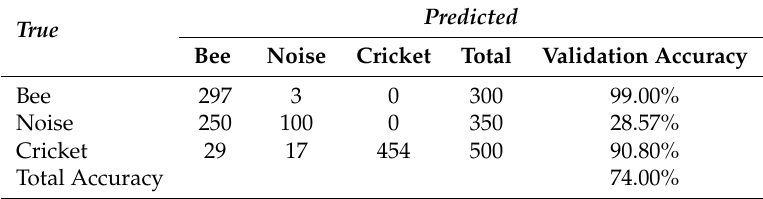
Table A6. Confusion matrix for ConvNet 1 with receptive field size n = 80 on BUZZ1 validation dataset.